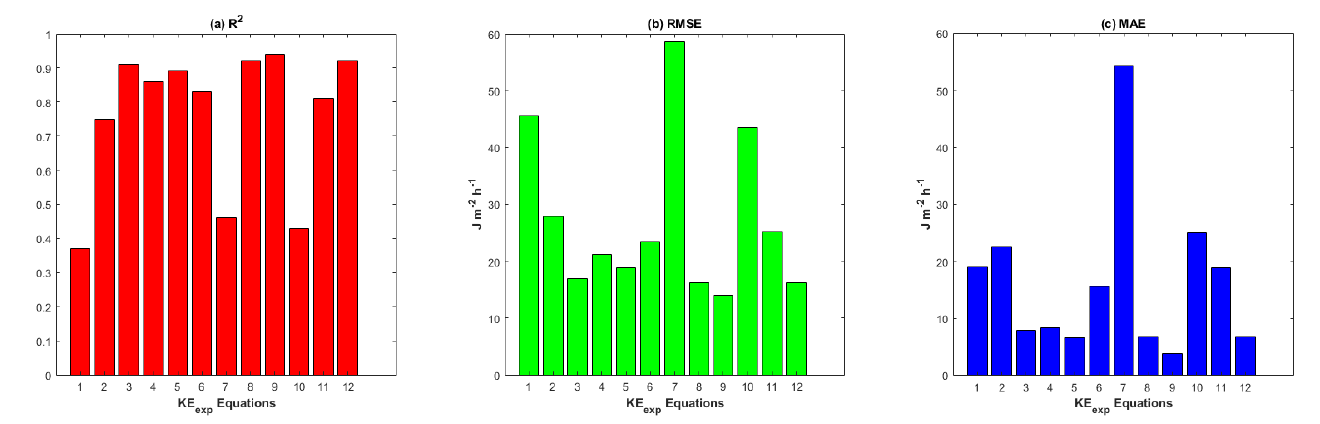
Figure 5 . Statistical analysis results of 12 KE exp –I r relationships with observed data. Figure 5. Statistical analysis results of 12 KE exp –I r relationships with observed Table 4. Statistical analysis results of 12 relationships between KE exp and I r in the literature.